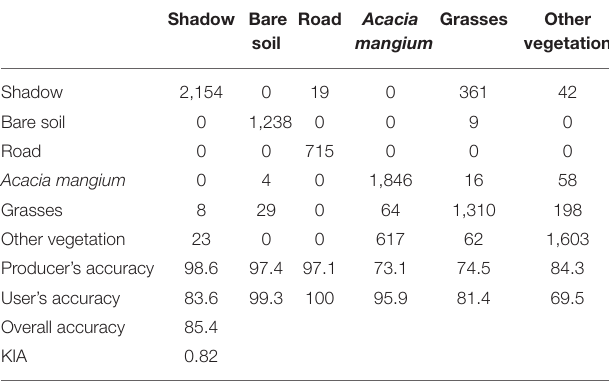
TABLE 5 | Confusion matrix and accuracy results of semi-automatic classification using the Semi-Automatic Classification Plugin ( Congedo, 2016) in open-source Quantum GIS.